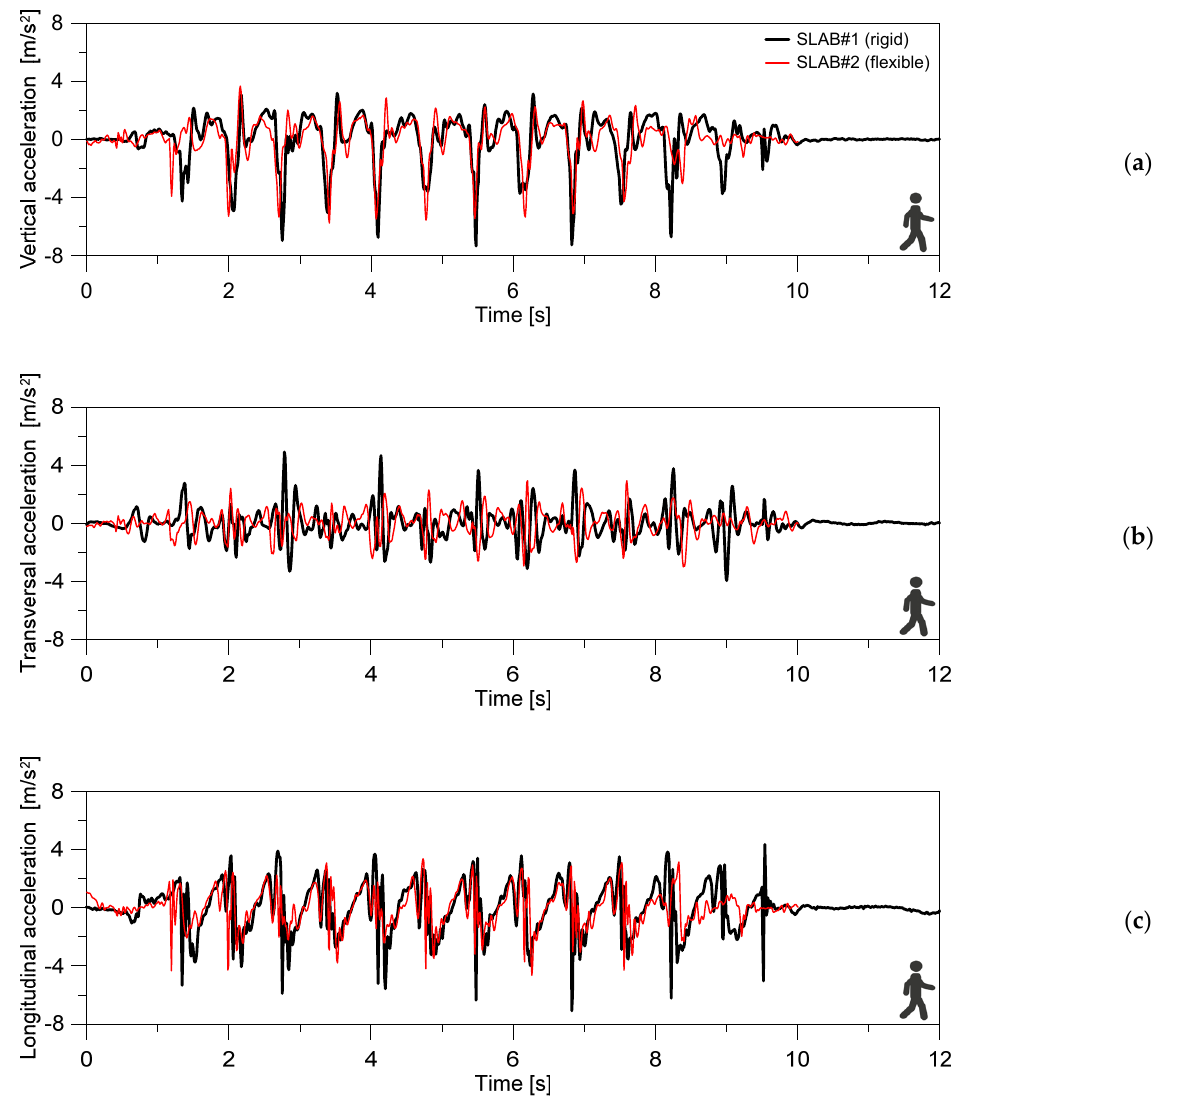
Figure 6. Example of experimental body CoM accelerations in time (W0 setup) for the volunteer moving on a rigid slab (SLAB#1) or a flexible substructure (SLAB#2).